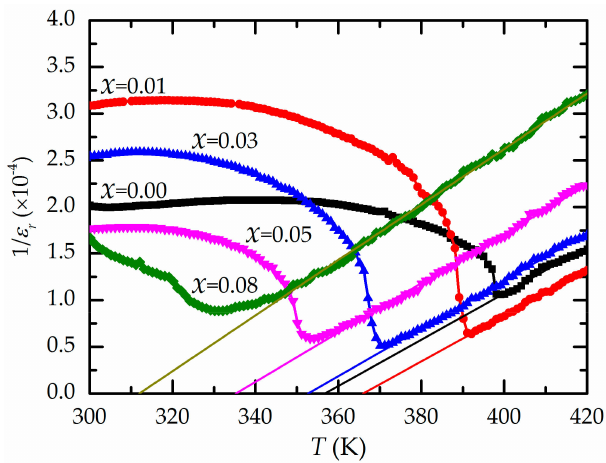
Figure 5. Relationships between the temperature and the inverse dielectric constant at 1 kHz for all the Ba(Zr x Ti 1 − x )O 3 ceramics.